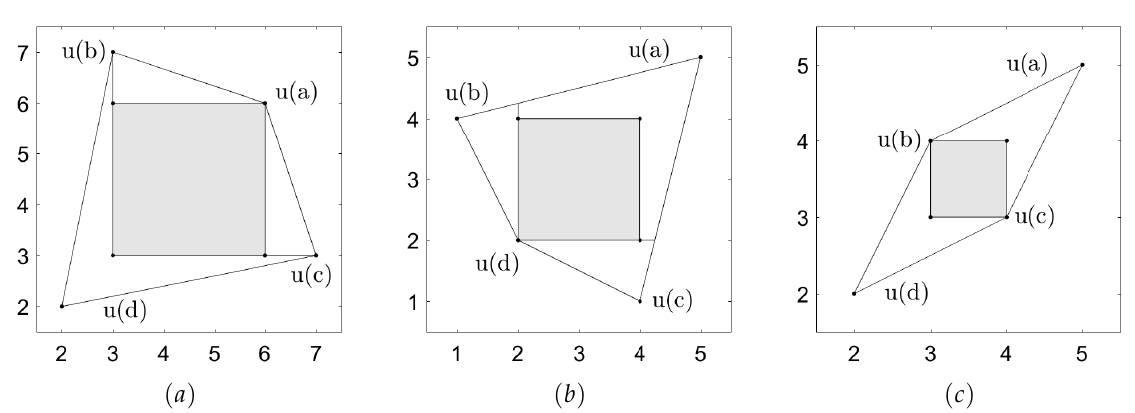
Figure 1. Self-supporting sets in ( a ) chicken, ( b ) stag hunt and ( c ) no conflict games. The players’ payoffs of action profiles a , b , c and d are denoted by u ( a ) to u ( d ) ,